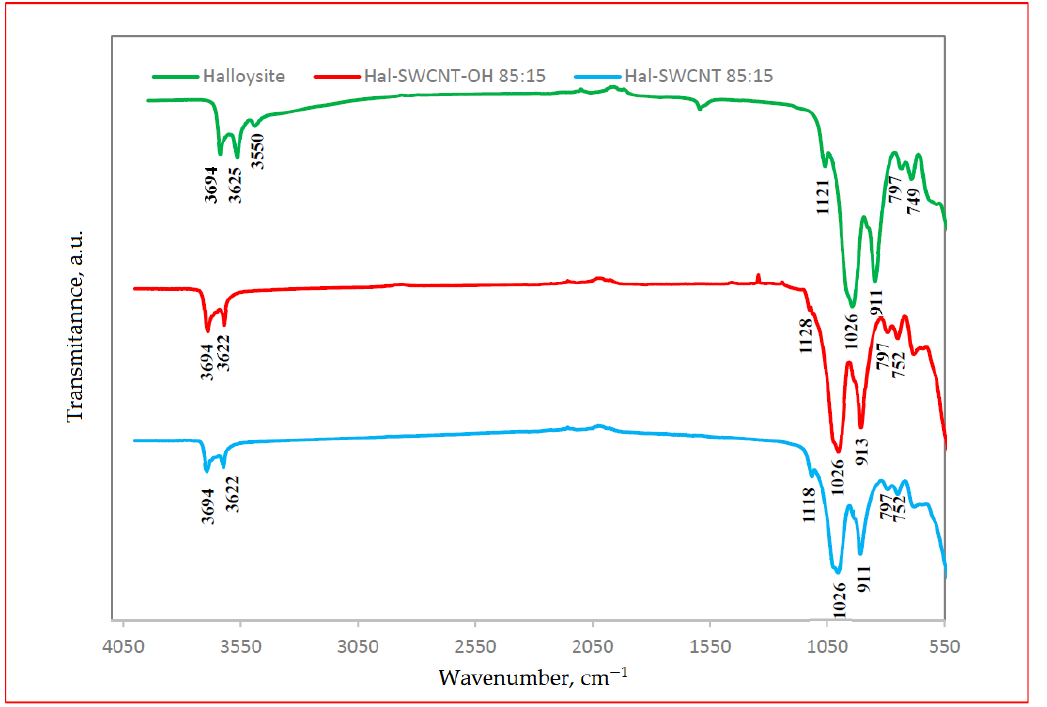
Figure 4. ATR-FTIR spectra of Hal, Hal-SWCNT 85:15, Hal-SWCNT-OH